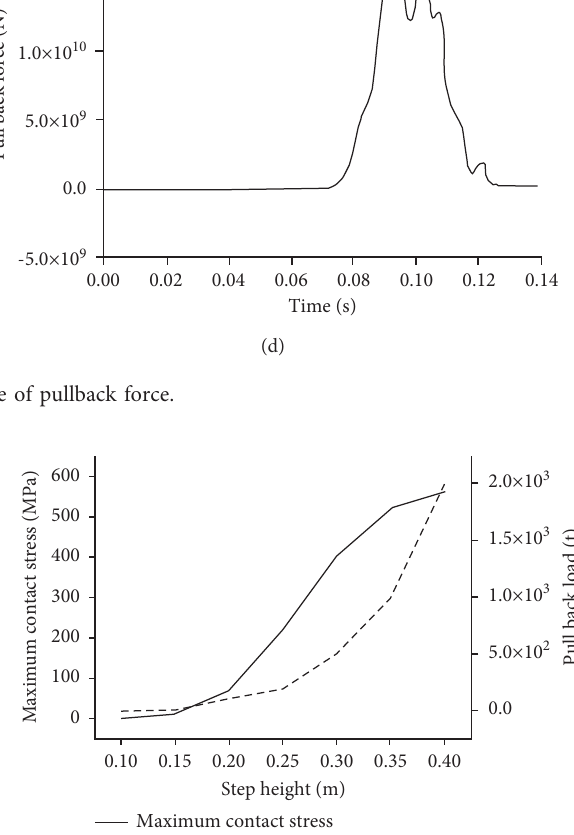
Figure 7: Relationship between step height, pullback force, and contact